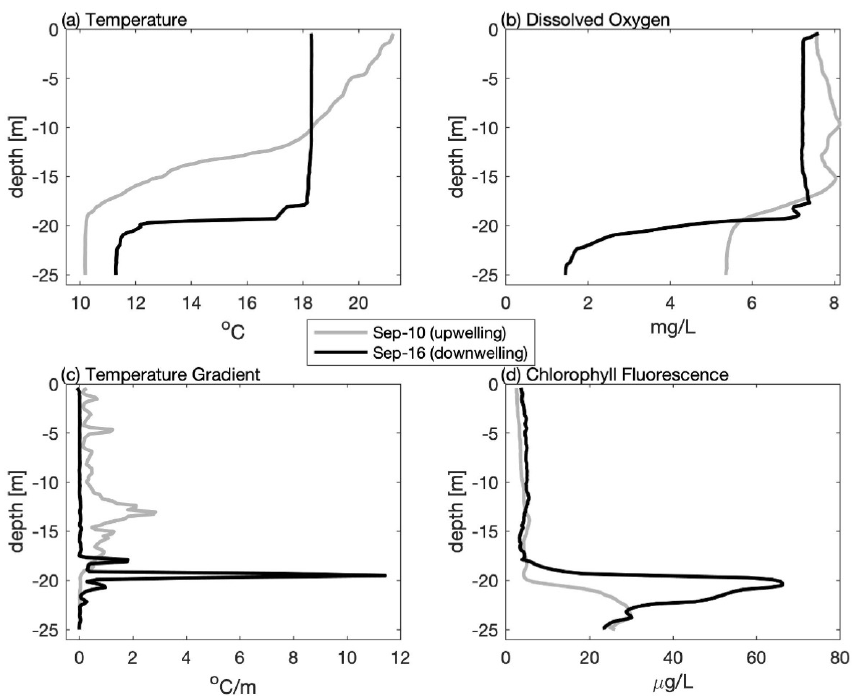
Figure 4. Vertical profiles from the mid-shelf ( ∼ 41.82 ◦ N) collected during late summer 2020 including (a) temperature, (b) dissolved oxygen, (c) vertical temperature gradient, and (d) chlorophyll fluorescence highlighting the difference following upwelling (10 September grey line) and downwelling (16 September black line) conditions. Note that even though the top-to-bottom temperature difference is greater following upwelling, downwelling results in a stronger temperature gradient, thinner bottom boundary layer, lower dissolved oxygen, and higher sub-surface chlorophyll